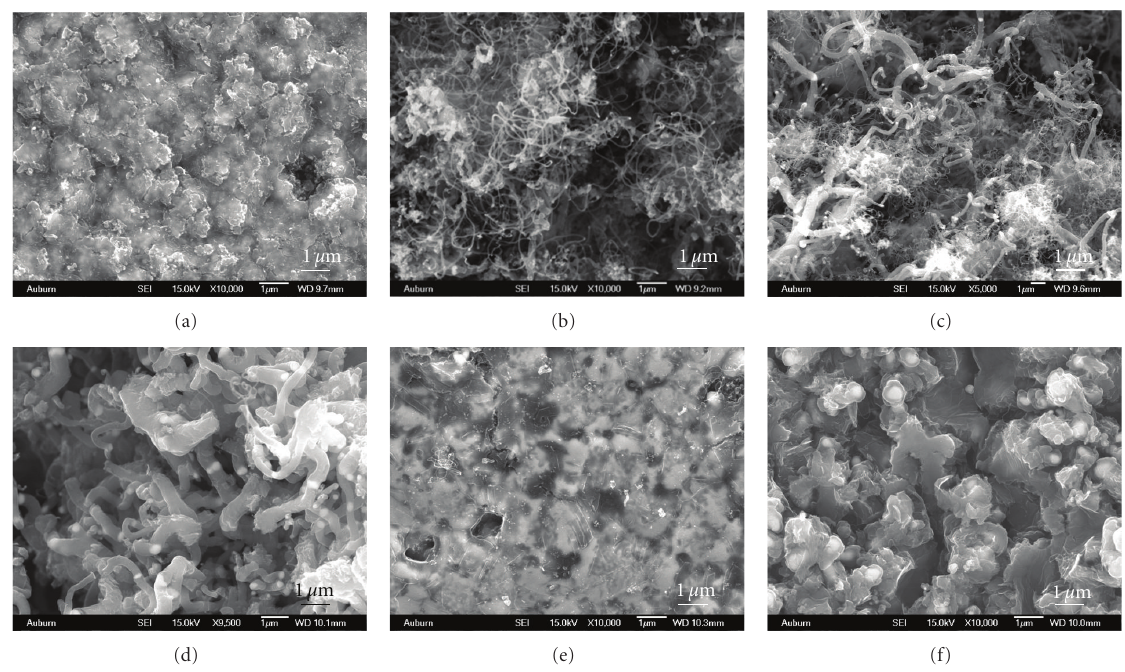
Figure 6: CNF growth in 10% H 2 (2% C 2 H 2 , 88% N 2 ). Temperature: (a) 420 ◦ C, (b) 470 ◦ C, (c) 520 ◦ C, (d) 570 ◦ C, (e) 670 ◦ C, and (f) 770 ◦ C. Sample faceted at 815 ◦ C (Table 1 (Phase 2)).